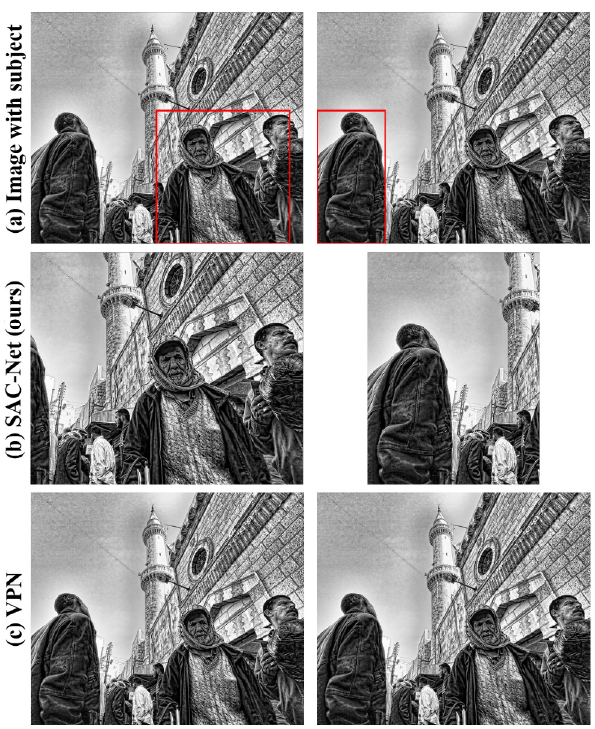
Fig. 10 Sample images used in the second user study. (a) Input image with multiple objects; red box indicates the specified subject. (b) Cropping results of SAC-Net. (c) Cropping results of VPN, an example of methods predicting general